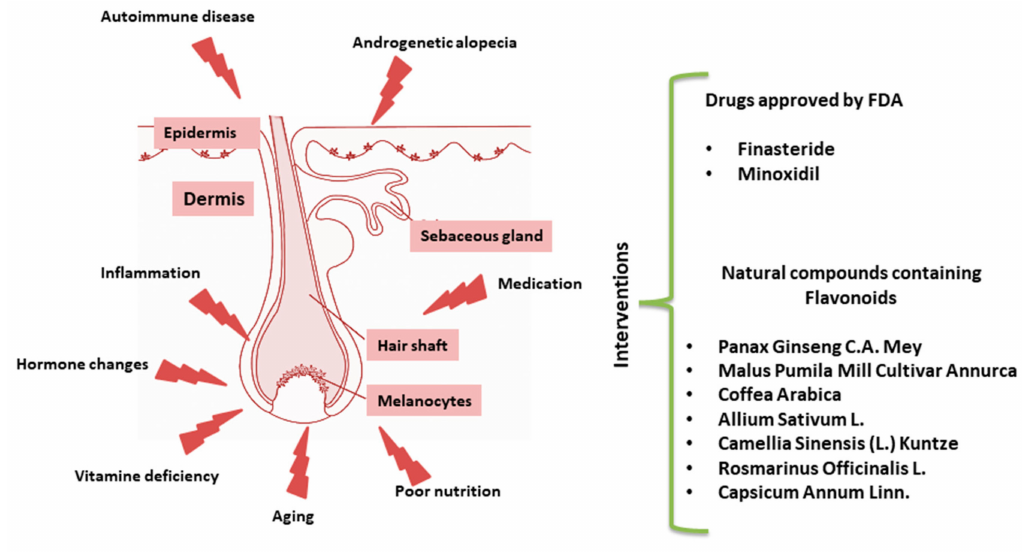
Figure 1. Schematic representation of hair follicle (HF) disruption. List of pharmacological drugs approved by Food and Drug Administration (FDA) or natural